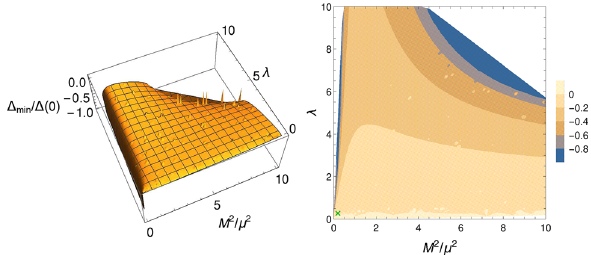
Fig. 14 Themagnitudeoftheviolationofreflectionpositivityobtained from the ratio min 0 < t < ∞ (cid:6)( t )/(cid:6)( t = 0 ) of the Schwinger functions in the larger range of parameters, (left) 3D plot, (right) contour plot